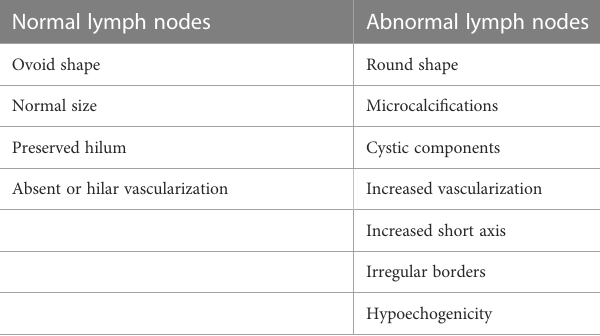
TABLE 2 Ultrasound features of normal vs . abnormal lymph nodes